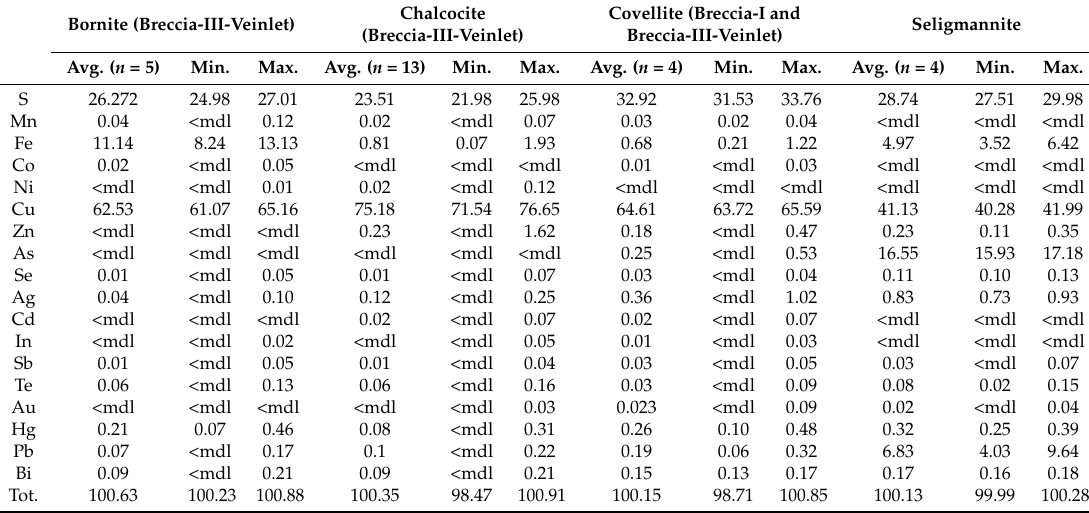
Table 5. Summary of average EPMA data for supergene sulfides and seligmannite from the Shah-Ali-Beiglou epithermal deposit (concentrations in wt